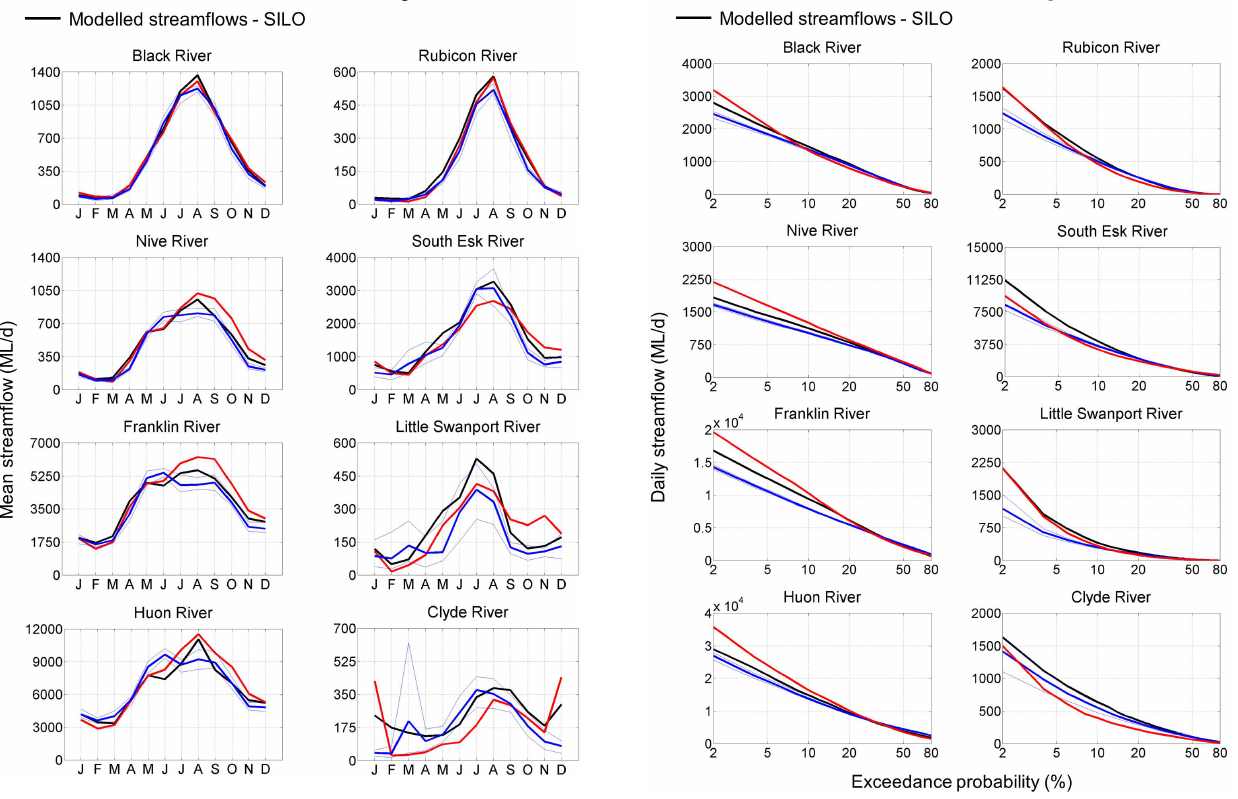
Fig. 9. Comparison of streamflow durations for observed and mod- elled daily streamflows 1961–2007. Blue line shows streamflows modelled with SIMHYD forced by the RCM, faint blue lines give range of the six RCM simulations, black line shows SIMHYD forced by SILO and red line shows gauged